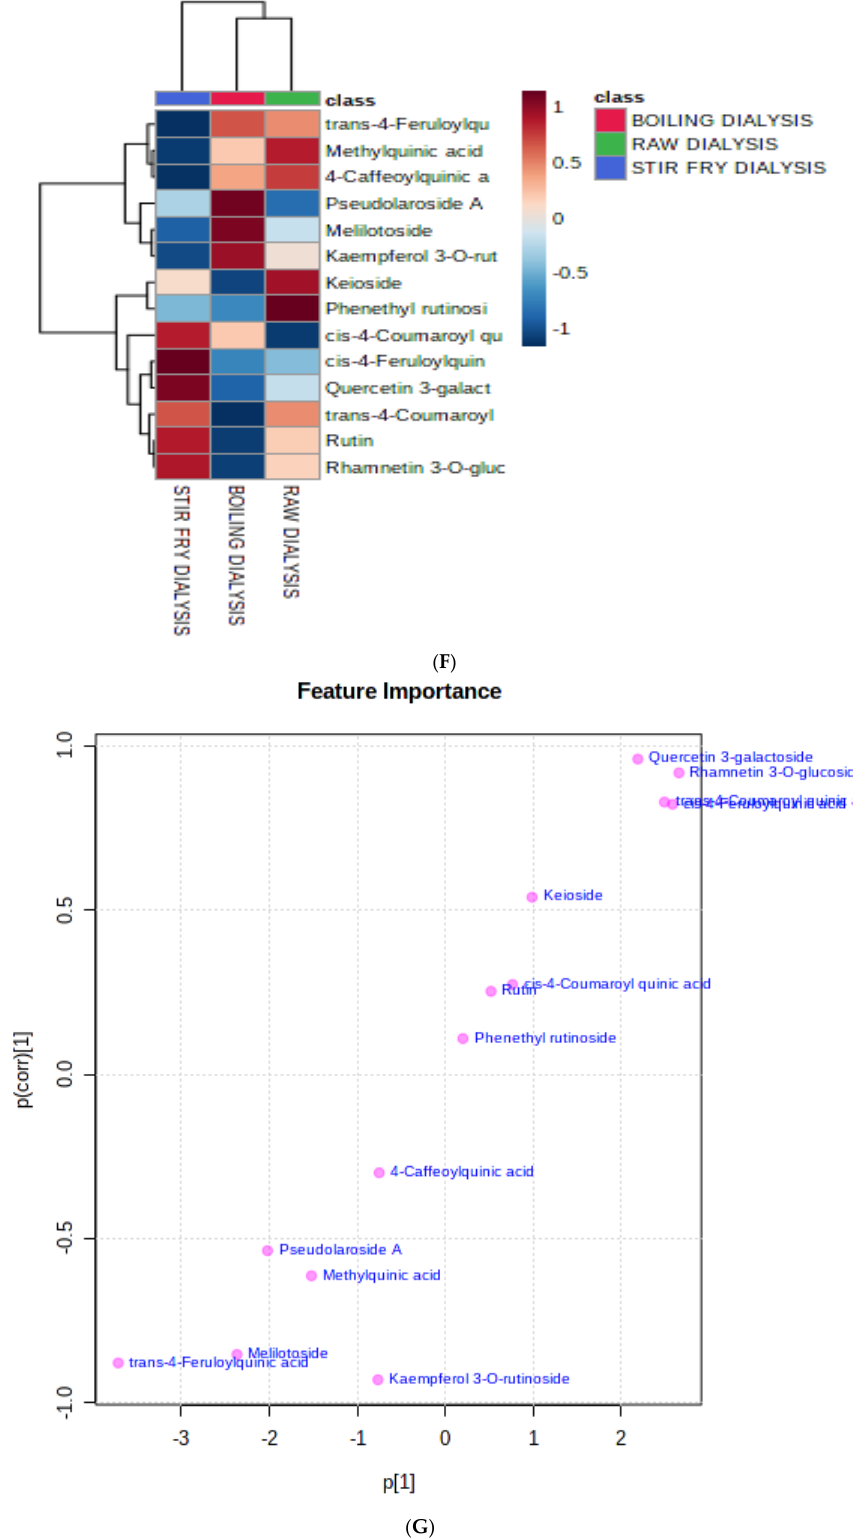
Figure 1. ( A ). Statistical analyses of bioactive metabolites, by using the Metaboanalyst 4.0 software, illustrating the unsu- pervised PCA score plot of bioactive metabolites of dialysable digesta of stir-fried, boiled or raw African pumpkin leaves generated by UPLC-QTOF/MS analysis and the separation of three clusters. ( B ) Illustration of the PC 1 and PC2 loadings of bioactive metabolites generated by the UPLC-QTOF/MS analysis from the dialysable digesta of stir-fried, boiled and raw leaves responsible for the separation of three different clusters. ( C ) Supervised PLS-DA score plot showing separation of three clusters for dialysable digesta of stir-fried, boiled and raw leaves based on bioactive metabolites generated by the UPLC-QTOF/MS analysis. ( D ) Illustration of the PC 1 and PC2 loadings of PL-SA analysis. Bioactive metabolites generated by the UPLC-QTOF/MS analysis from the dialysable digesta of stir-fried, boiled and raw leaves responsible for the sepa- ration of three different clusters. ( E ) VIP scores of bioactive metabolites in PLS-DA. The most abundant compounds in the dialysable digesta of stir-fried, boiled and raw African pumpkin leaves are represented by their m/z values, retention times (min). The scoring of the variables, ranging from low to high numbers, is according to their importance. On the right, the coloured boxes indicate the relative concentration of the corresponding metabolites. A red colour indicates high level, and a blue colour indicates a low level. ( F ) Heat map. The coloured areas on the map correspond to concentrations of different bioactive metabolites present in the dialysable digesta of stir-fried, boiled or raw African pumpkin leaves. Bioactive me- tabolites are in rows, and different household cooking techniques are in columns. The red colour indicates high levels and the blue colour low levels. ( G ) showing the OPLS-DA loadings S-plot and the compounds responsible for the separation of dialysable digesta of stir-fried leaves from the boiled and raw leaves.